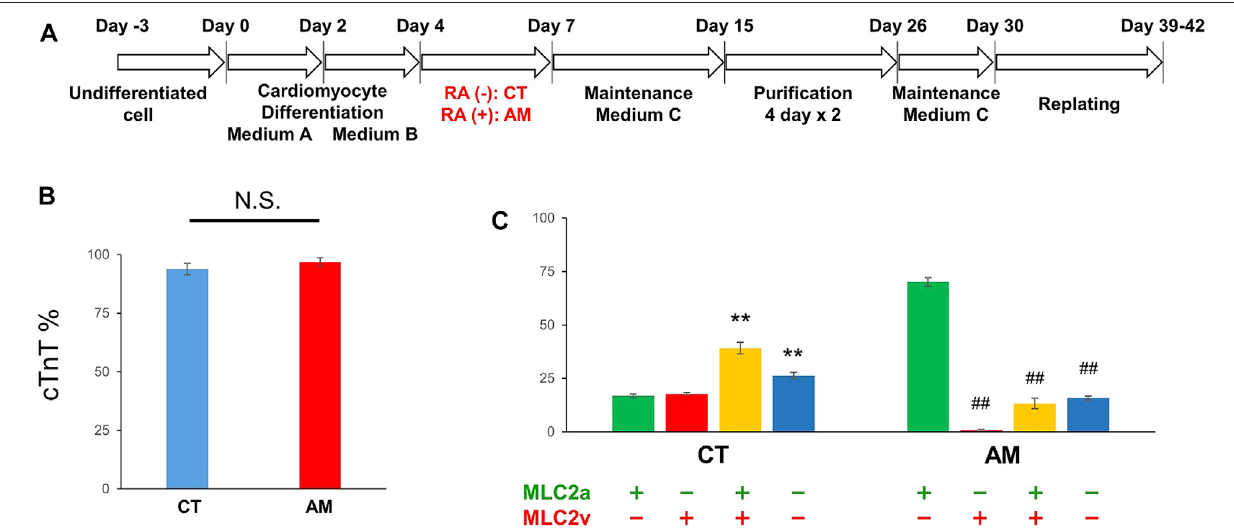
FIGURE 1 | Cardiac differentiation from hiPSCs (A) Schematic of the protocol for the differentiation of cardiomyocytes from hiPS cells with (RA (+)) or without RA (RA( − ))treatment (B) Theratioofcardiomyocytesquanti fi edbyimmunostainingwithcardiactroponin-T(cTnT).TheproportionofcTnTpositivecellswas93.91 ± 2.51% in CT (control hiPS-CMs), or 96.79 ± 1.81% in AM (RA-treated hiPS-CMs), respectively (P (cid:2) N.S.). Error bars represent SD of the mean from the values of independent experiments. n (cid:2) 3. N.S., not signi fi cant (C) Immuno fl uorescence analysis of the percentage of MLC2a (atrial isoform) and MLC2v (ventricular isoform) positive expression in the CT and AM. Error bars represent SD of the mean from the values of independent experiments. ** p < 0.01 for comparison with MLC 2a+/MLC 2v-cardiomyocyte in CT, ## p < 0.01 for comparison with MLC 2a+/MLC 2v-cardiomyocyte in AM, n (cid:2) 3.